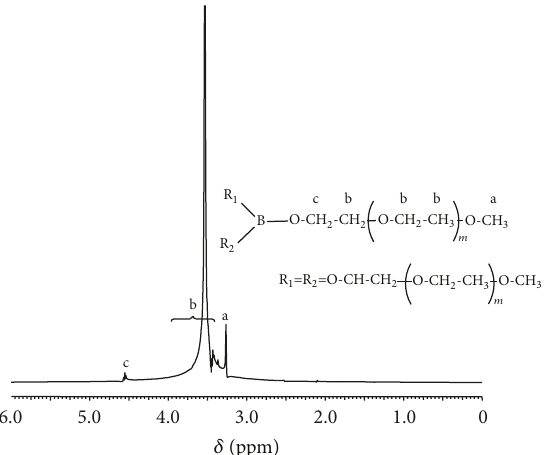
Figure 3: Comparison of FTIR spectra of PEGME350 (a); PEGME350-B (b); and PEGME350-B- 𝑌 , ( 𝑌 = 100 (c), 75 (d), 50 (e), and 25 (f)).